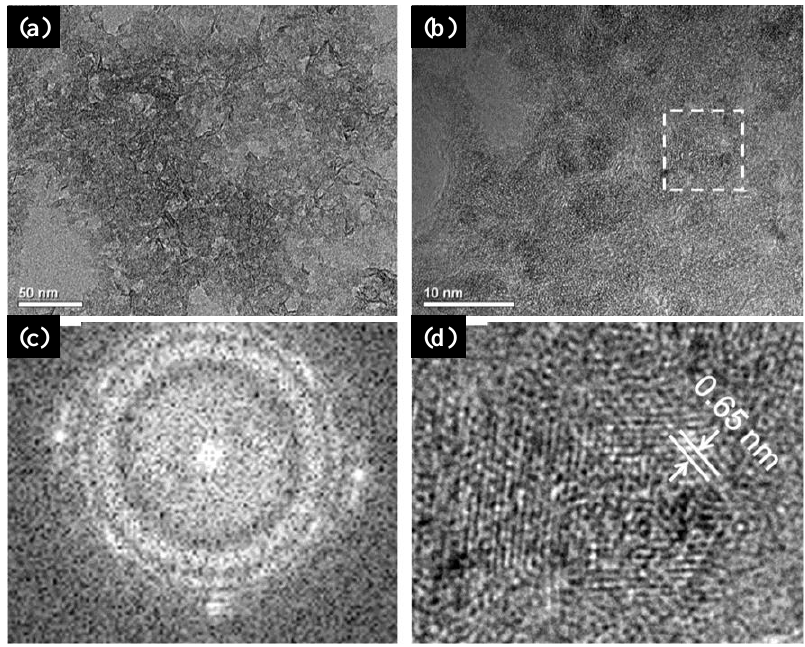
Figure 10. ( a ) TEM and ( b ) HRTEM image of the as-synthesized catalysts. ( c ) the fast Fourier transition (FFT) image of the selected area, and ( d ) inverse fast Fourier transition (IFFT) image obtained from ( c ). Figure adapted with permission from Reference [164]. Copyright 2010 Elsevier.